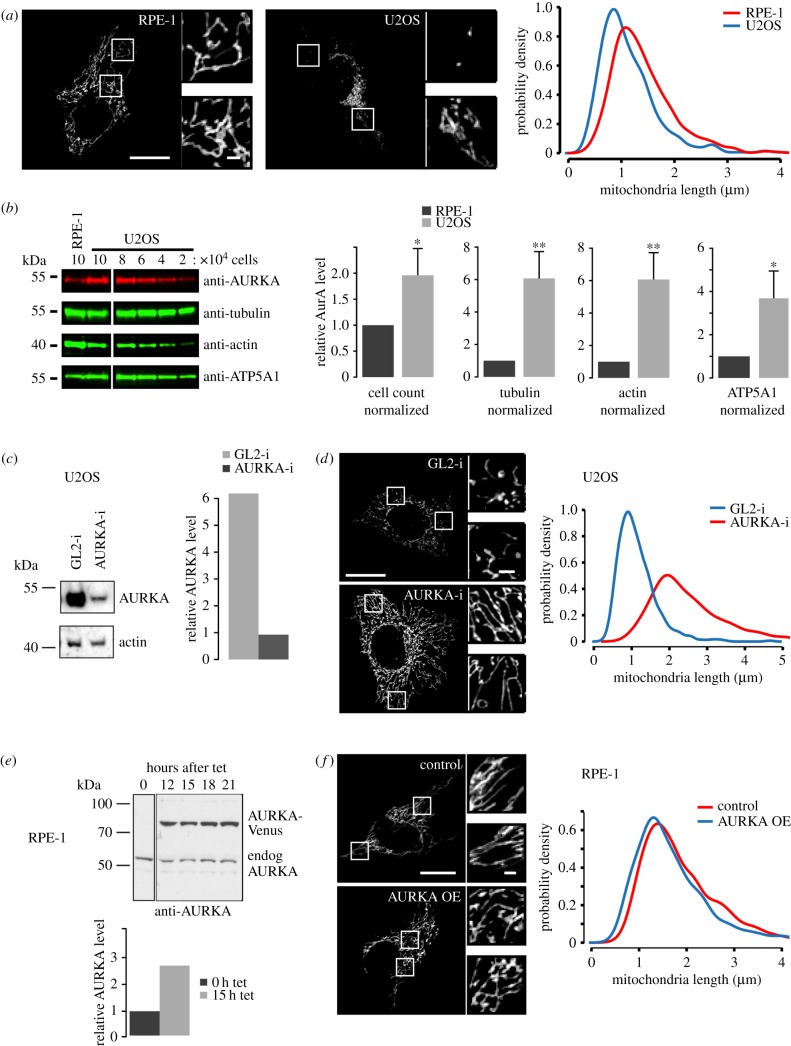
AURKA levels influence mitochondrial morphology in RPE-1 and U2OS cells. (a) RPE-1 and U2OS cells were treated with MitoTrackerTM and imaged under identical conditions. Mitochondrial lengths were measured and plotted as in figure 1. p < 0.001 for the maximum deviation D = 0.37 (K-S test) from two repeats. (b) Equal numbers of U2OS and RPE-1 cells were harvested for cell extracts and calculated quantities loaded onto gels to be examined by quantitative immunoblot. Bar charts show AURKA levels quantified and normalized against number of cells, or against different loading markers. Statistical confidence is indicated as *p < 0.01; **p < 0.001 (Student's t-test), n = 3 repeats. (c,d) U2OS cells were treated with control (GL2-i) or AURKA siRNA (AURK-i) for 48 h and then either processed for quantitative immunoblotting of AURKA levels (c) or stained with MitoTrackerTM (d). Example images show insets indicated by white boxes magnified twofold. Mitochondrial tubular length measurements are plotted as probability density curves. p < 0.001, D = 0.73 (K-S test). (e,f) RPE-1-AURKA-Venus cells were induced for AURKA-Venus expression (AURKA OE) or not (control) with addition of tet for 18 h. Cells were either processed for quantitative immunoblotting of AURKA levels (e) or stained with MitoTrackerTM for mitochondrial tubular length measurements (f), p < 0.01, D = 0.08 (K-S test). tet, tetracycline; endog, endogenous; OE, overexpression. For panels (a,d,f): scale bars, 10 µm in main panels, 1 µm in magnification panels.